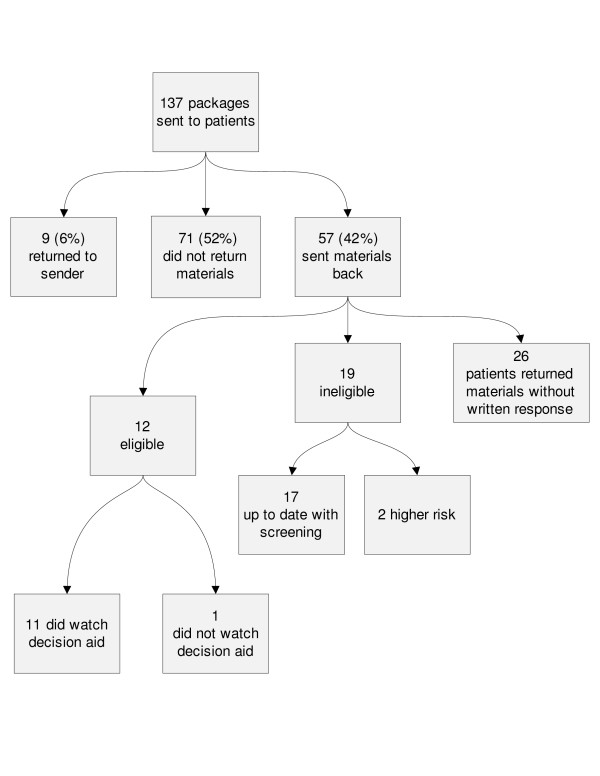
Response to mailing.